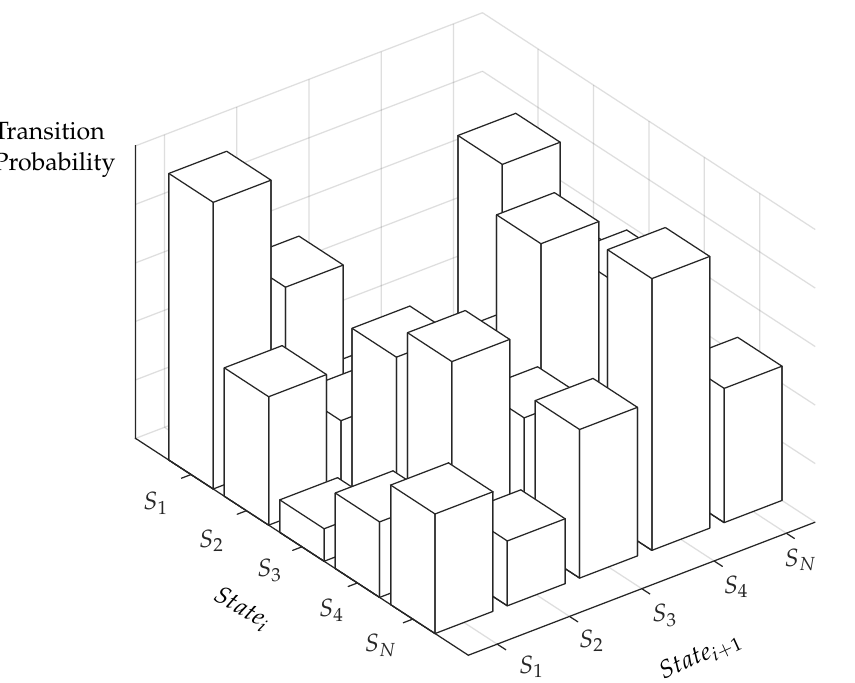
Figure 2. Visualisation of Transition Probability Matrix (TPM).